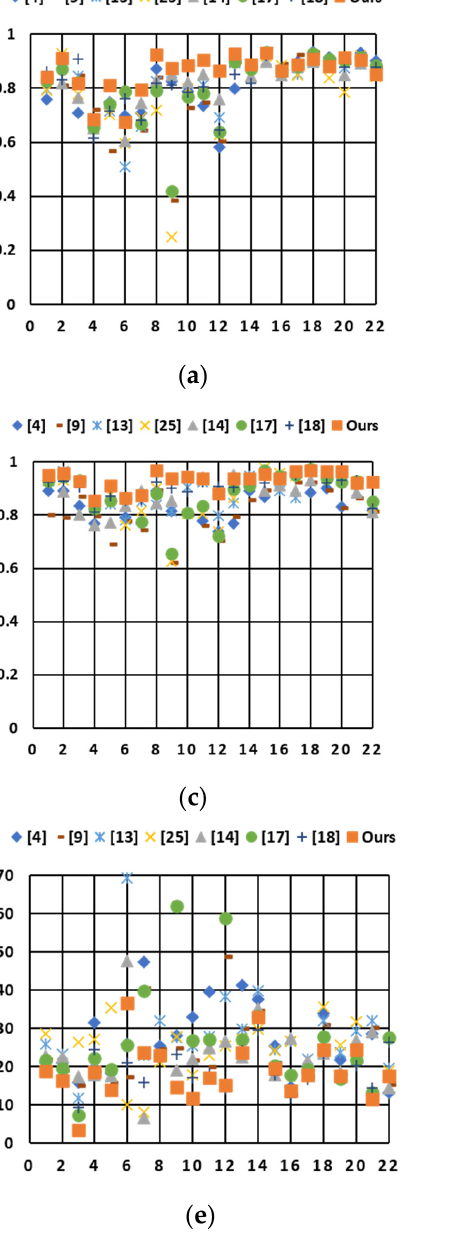
( g ) Figure 11. Comparison of scatter plots using the twenty-two test images, where the horizontal axis indicates the image order, and the vertical axis indicates the objective quality index. ( a ) Result of TMQI-S. ( b ) Result of TMQI-N. ( c ) Result of TMQI-Q. ( d ) Result of FSITM-TMQI. ( e ) Result of BRISQUE. ( f ) Result of BTMQI. ( g ) Result of IL-NIQE. With regard to the no-reference quality assessments (BRISQUE, BTMQI, and IL- NIQE), our methods all obtained the best scores of the average BRISQUE, BTMQI, and IL- NIQE. By considering both global and local features to generate a virtual combined histogram, this method maintains the naturalness of an image and produces an output reproduced image with high image quality. Compared with global- and local-based reproduction methods that consider only global features (or only local features), our method can simultaneously take advantage of global and local features. Compared with the decomposition-based methods, our method does not need to process the base and detail layers separately, thus avoiding unnaturalness when blending different image layers. Overall, in Table 3, our method achieved the highest score in all seven assessments, indicating its excellent performance with natural-looking and rich information. For the subjective analysis and evaluation, we invited 20 participants (10 males and 10 females) to take a subjective visual quality test. The participants were asked to rate the visual subjectiveness of all the images without knowing the applied method on the output images of twenty-two scenes using the eight comparative algorithms. The score ranges from 1 to 10 points, where 1 point means “unsatisfied” and 10 points means “excellent”. The mean and standard deviation of the mean opinion scores (MOS) of the subjective users are shown in Figure 12, where the proposed method is significantly better than the other methods. In addition, the abovementioned FSITM-TMQI is actually obtained by averaging the scores of RGB channels, i.e., the FSITM-R, FSITM-G, and FSITM-B, respectively. The FSITM quality evaluation index is based on using the local phase similarity to construct a noise-independent feature map in the R, G, and B planes. In view of this, we further